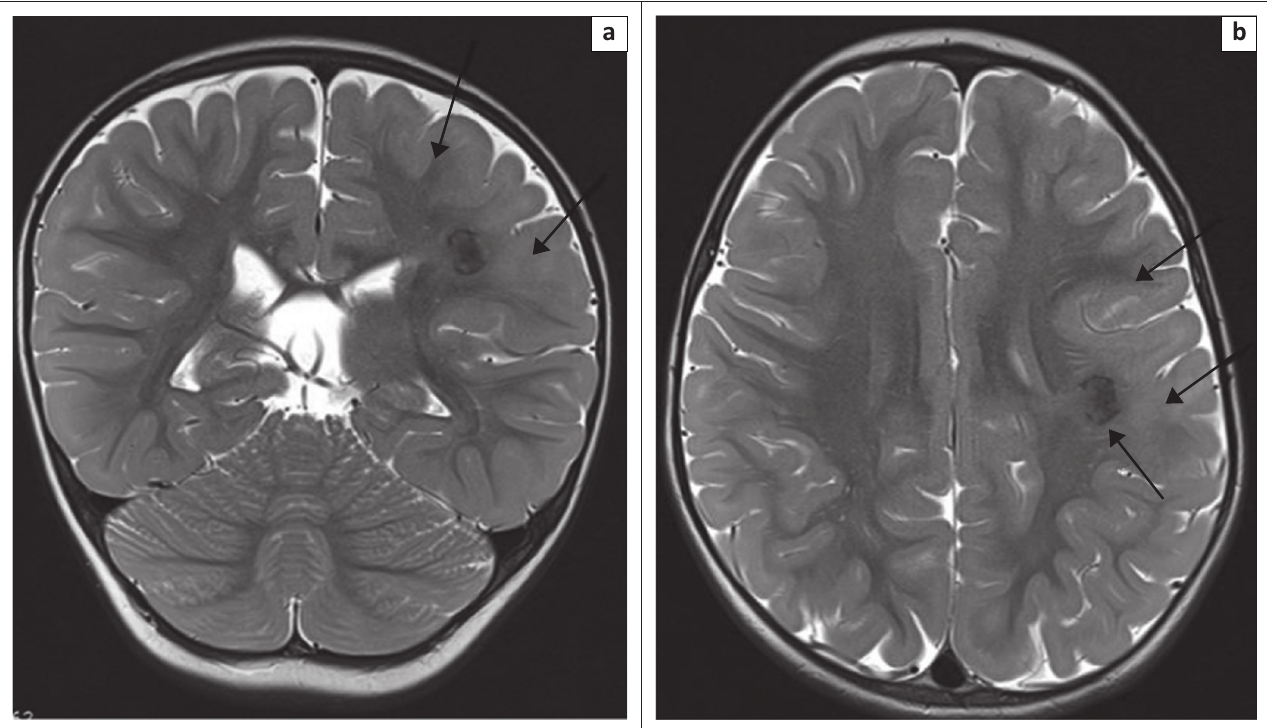
FIGURE 2: Twenty-month-old child with drug-resistant seizures from birth. Coronal (a) and axial (b) T2W show left frontal cortical dysplasia characterised by cortical thickening and adjacent white matter abnormality extending to the ventricular margin (arrows). Note the mineralisation indicated byT2 hypointensity in the left subcortical white matter (arrowhead). Resection specimen revealed Palmini Type IIB focal cortical dysplasia and coexisting low-grade astrocytoma. Proximity of the posterior margin of the lesion to the central sulcus made surgical resection challenging in this patient.